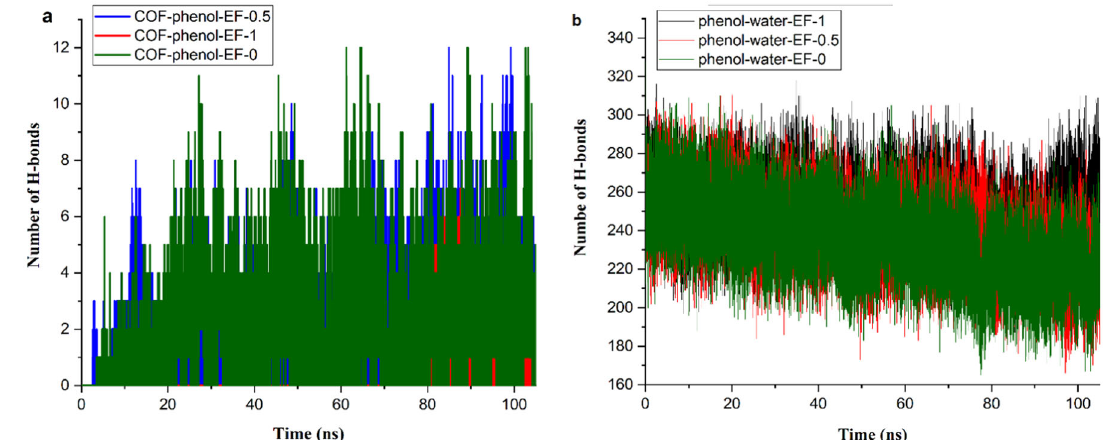
Fig. 4 The number of hydrogen bonds against the simulation time. a Between COF and phenol. b Between phenol and water.